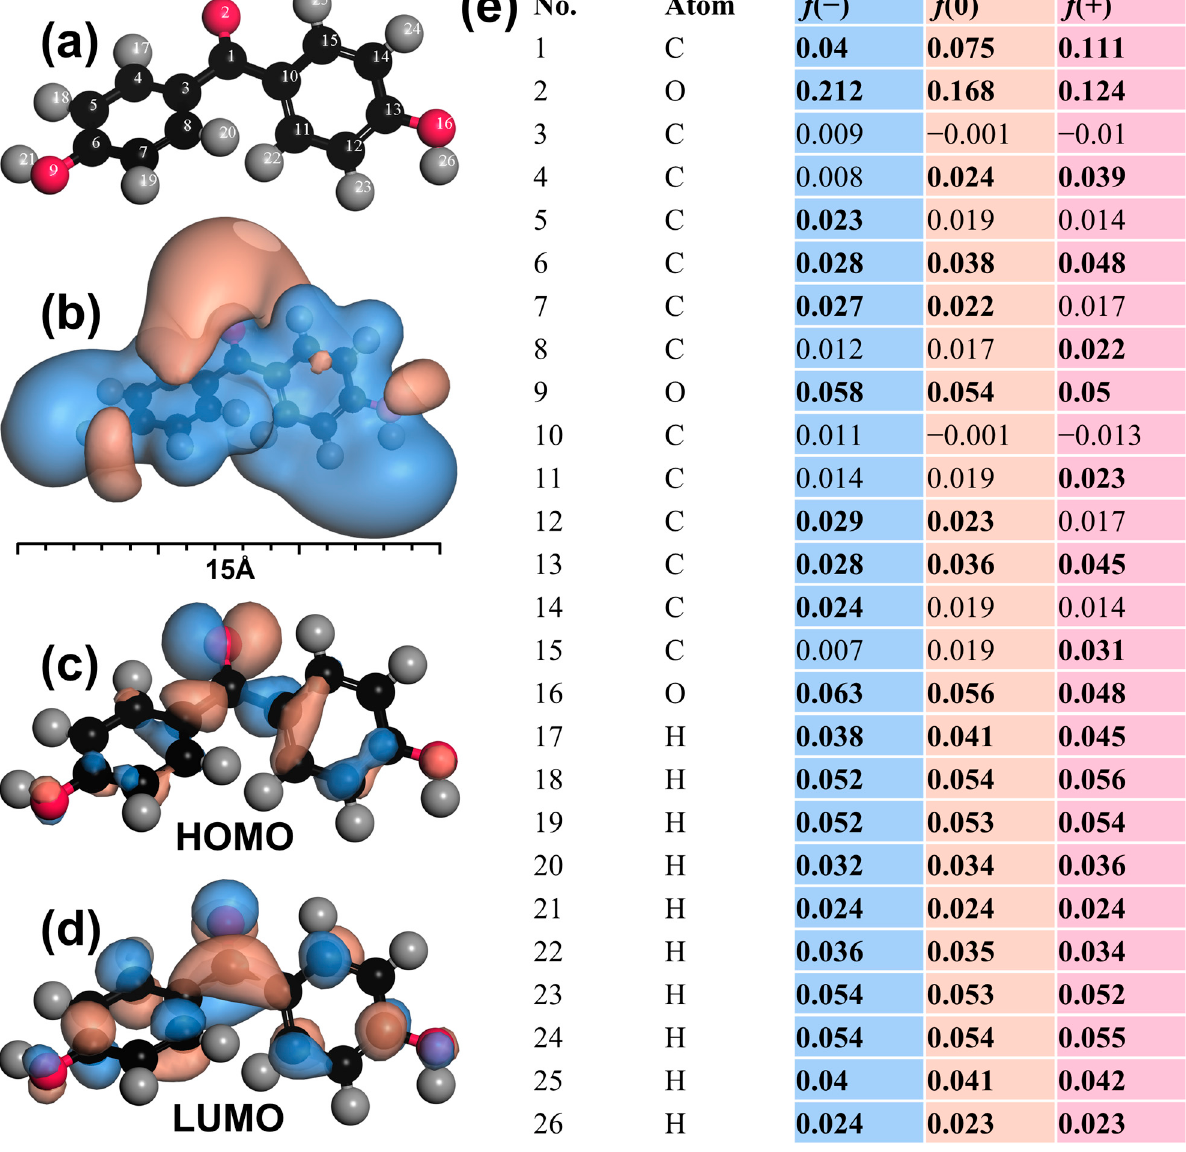
Figure 10. DFT calculation for BHPM: ( a ) the optimized molecule structure; ( b ) electrostatic potential (ESP); ( c ) the highest occupied molecular orbital (HOMO); ( d ) the lowest unoccupied molecular orbital (LUMO); and ( e ) condensed Fukui index distribution for electrophilic attack ( f − ), radical attack ( f 0 ), and nucleophilic attack ( f + ).